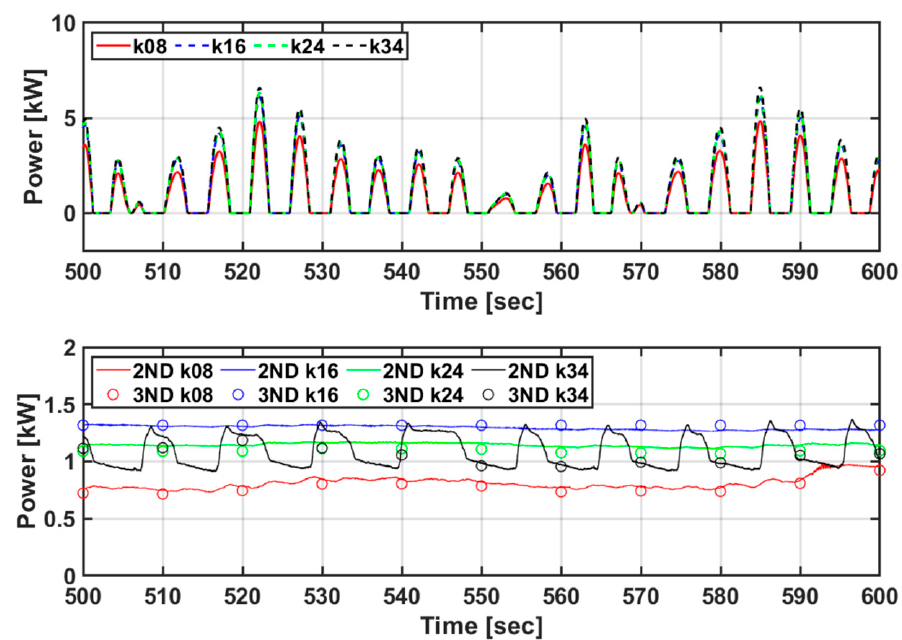
Figure 22. The result of comparing the generation amounts according to the torque coefficient of the optimal torque control algorithm under irregular wave conditions ( H s = 0.75 m, T p = 4.75 s) (legends indicate torque coefficients).